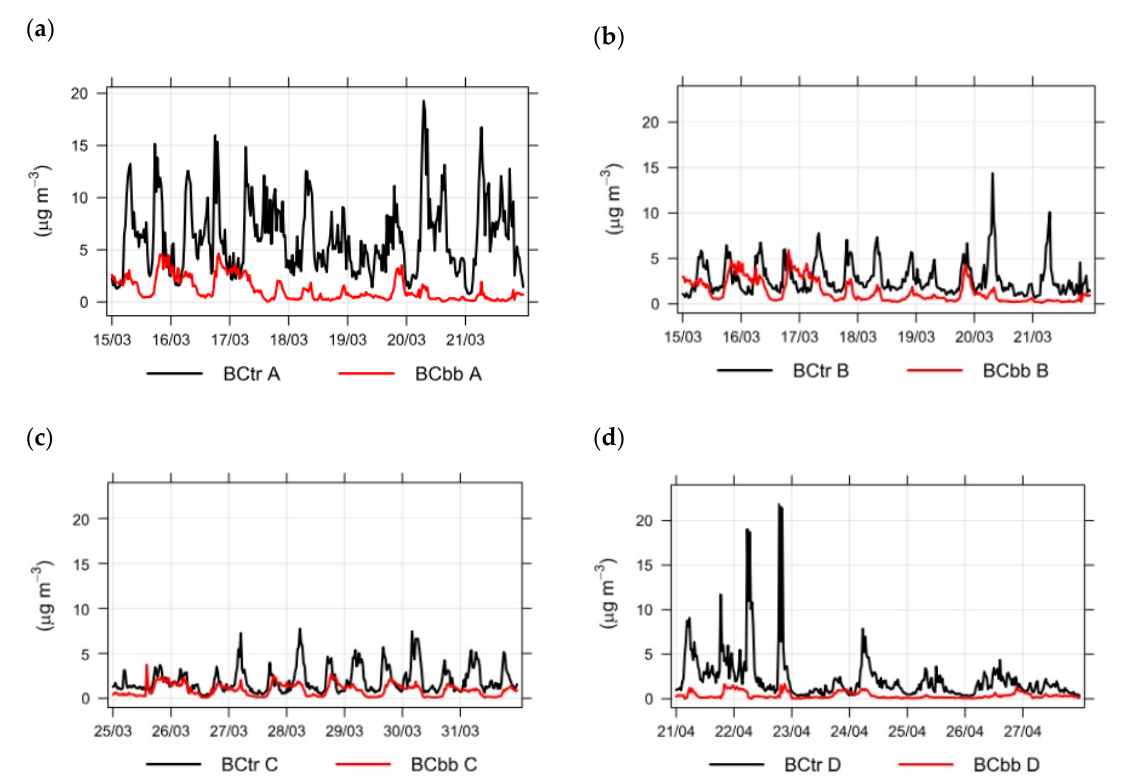
Figure 6. Comparison of springtime BC concentrations at measuring points A ( a ) compared to measuring points B ( b ), C ( c ), and D ( d ).